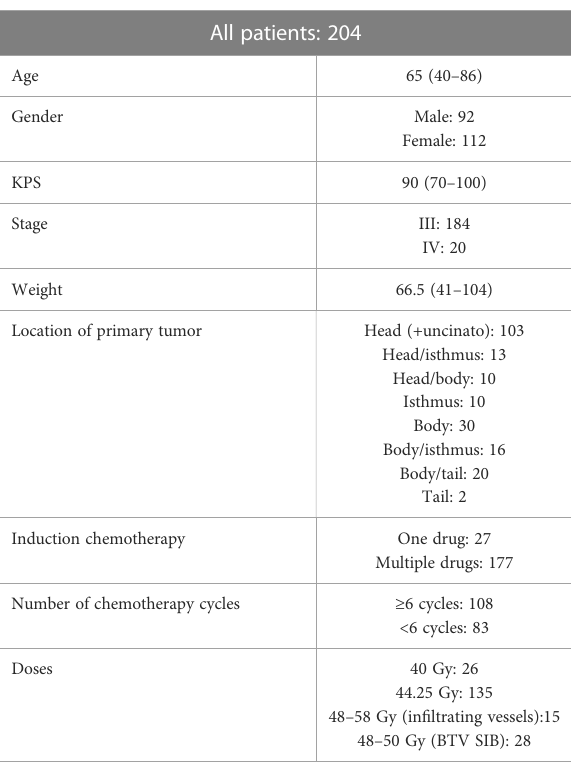
Table 1: 184 patients were in stage III, and 20 were in stage IV. Most patients (n = 177) received a combination of at least two drugs as induction chemotherapy. The median number of cycles was 6 (range, 2 – 13), and 108 patients received ≥ 6 cycles. Most patients (n = 135) were treated with a dose of 44.25 Gy; 26 patients with 40 Gy and 43 patients received a SIB of up to 48 – 58